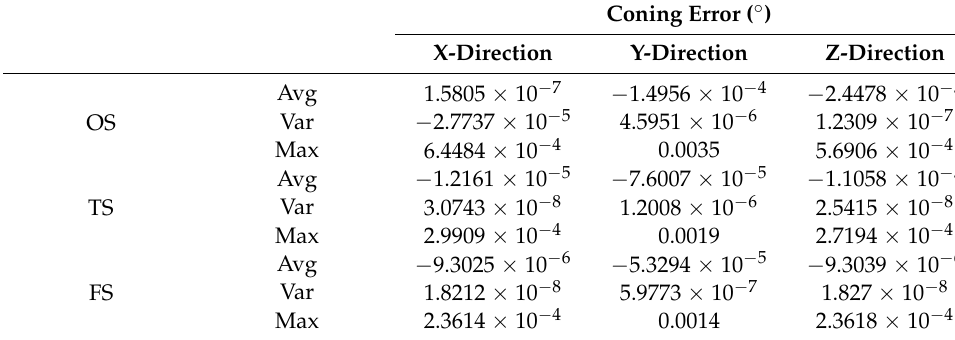
Table 2. The statistical properties of the simulation results for coning